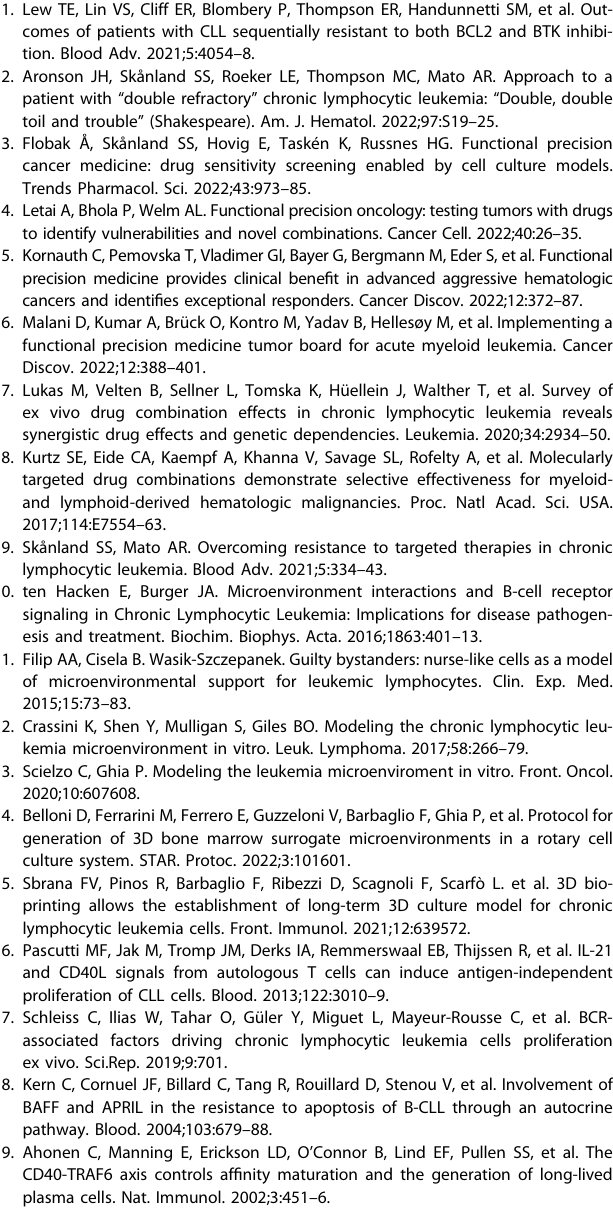
Fig. 4 Evolution of ex vivo drug sensitivity in response to sequential therapies and treatment stop. a Cropped time-line illustrating the treatment sequence for the CLL patient following ibrutinib therapy. T0-T4 indicate time-points when blood samples were collected from the patient. AE, adverse event; PD, progressive disease. The fi gure was created with BioRender.com. b PBMCs from T0-T4 were co-cultured with CD40L/APRIL/BAFF fi broblasts for 24 h to prevent spontaneous apoptosis of the CLL cells. The CLL cells were then separated from the fi broblast layer and treated with the indicated drug combinations for 72 h. Cell viability was assessed with the CellTiter-Glo luminescent cell viability assay. The drug sensitivity score was calculated for each treatment based on the area under the concentration-response curve. A high score indicates high sensitivity to the treatment. The heatmap was created using ClustVis (https://biit.cs.us.ee/clustvis/). c Freshly thawed peripheral blood mononuclear cells (PBMCs) from T0-T4 were fi xed, permeabilized and stained with antibodies against the indicated proteins (rows). Signals were detected in CD19 + B cells by fl ow cytometry. Raw data were transformed to an arcsinh ratio relative to the signal of an isotype control, which was set to zero. The heatmap was created using ClustVis (https://biit.cs.us.ee/clustvis/). Both rows and columns were clustered using Manhattan distance and Ward linkage algorithm. d , e Phosphorylation levels of BTK (pY223) and ERK1/2 (pT180/Y182) are shown for experiments described in ( c ). f , g PBMCs from T0-T4 were co-cultured with CD40L/APRIL/BAFF fi broblasts for 24 h to prevent spontaneous apoptosis of the CLL cells. The CLL cells were then separated from the fi broblast layer and treated with the indicated drug combinations for 72 h. Cell viability was assessed with the CellTiter-Glo luminescent cell viability assay. The drug sensitivity score was calculated for each treatment based on the area under the concentration-response curve. A high score indicates high sensitivity to the